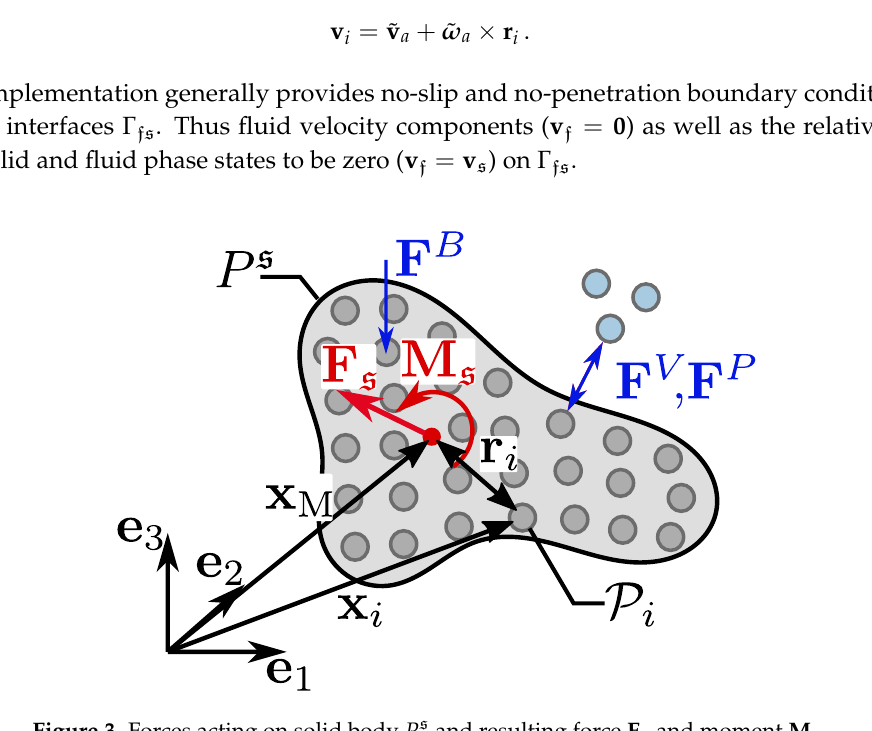
Figure 3. Forces acting on solid body P s and resulting force F s and moment M s